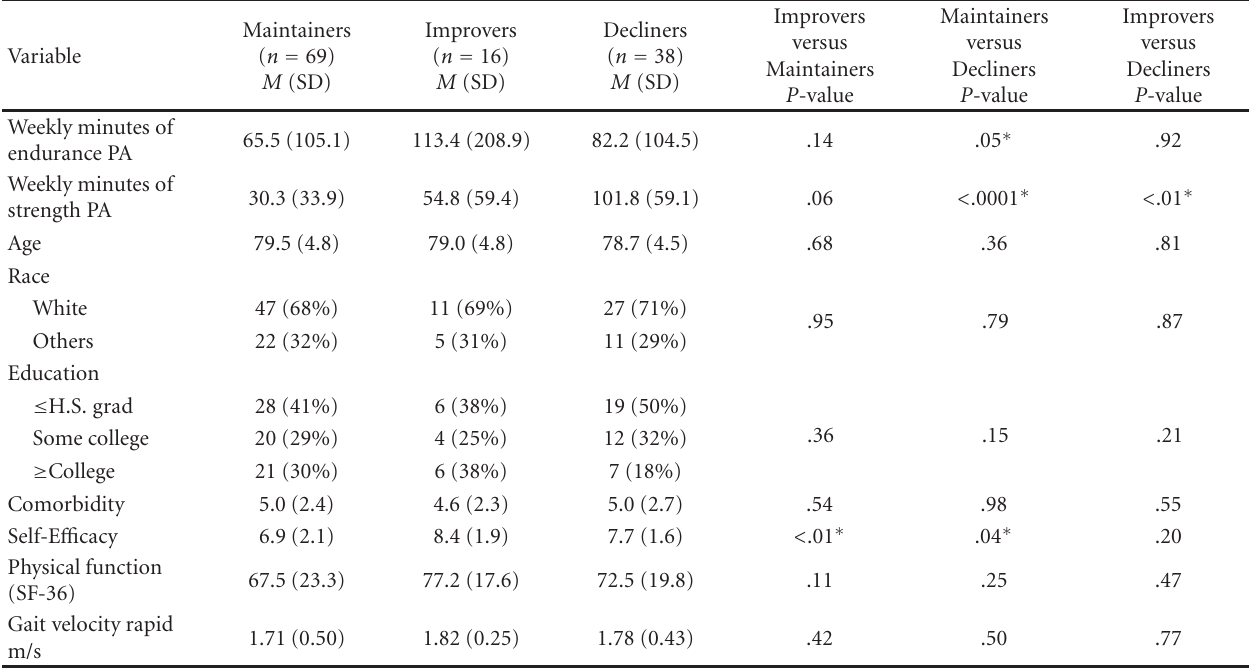
Table 3: Characteristics of maintenance, improvement, and decline from 12 to 24 months: minutes of moderate-intensity strength PA.